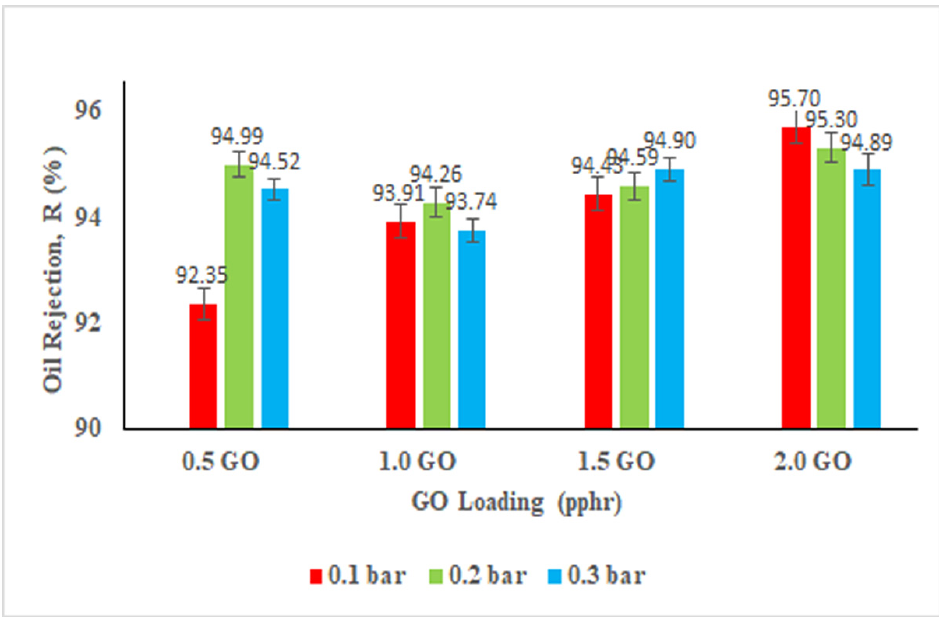
Figure 8. Oil rejection (%) of the membranes at different operating pressures.